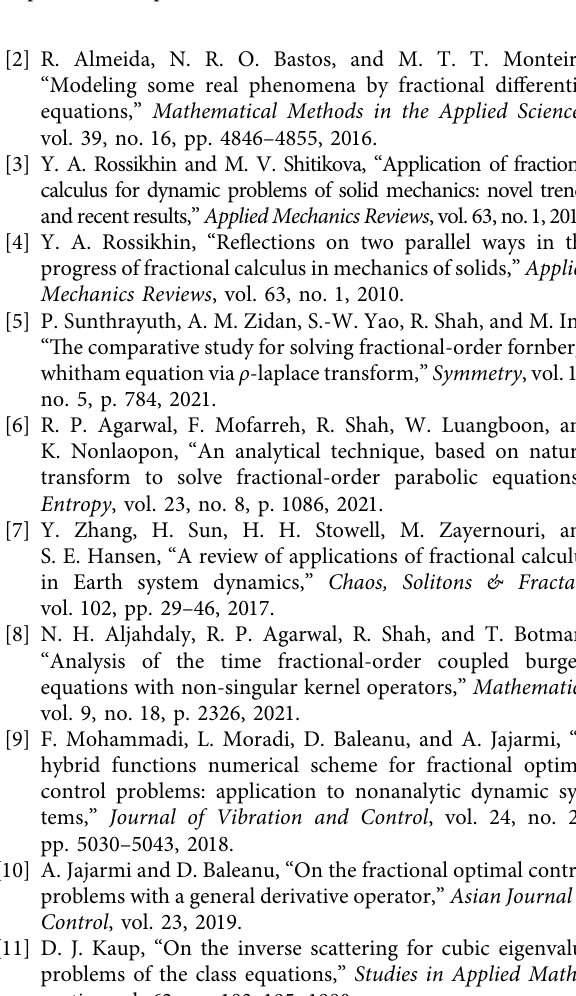
Figure 7: The fractional order ρ of Example 3 with respect to ζ and τ